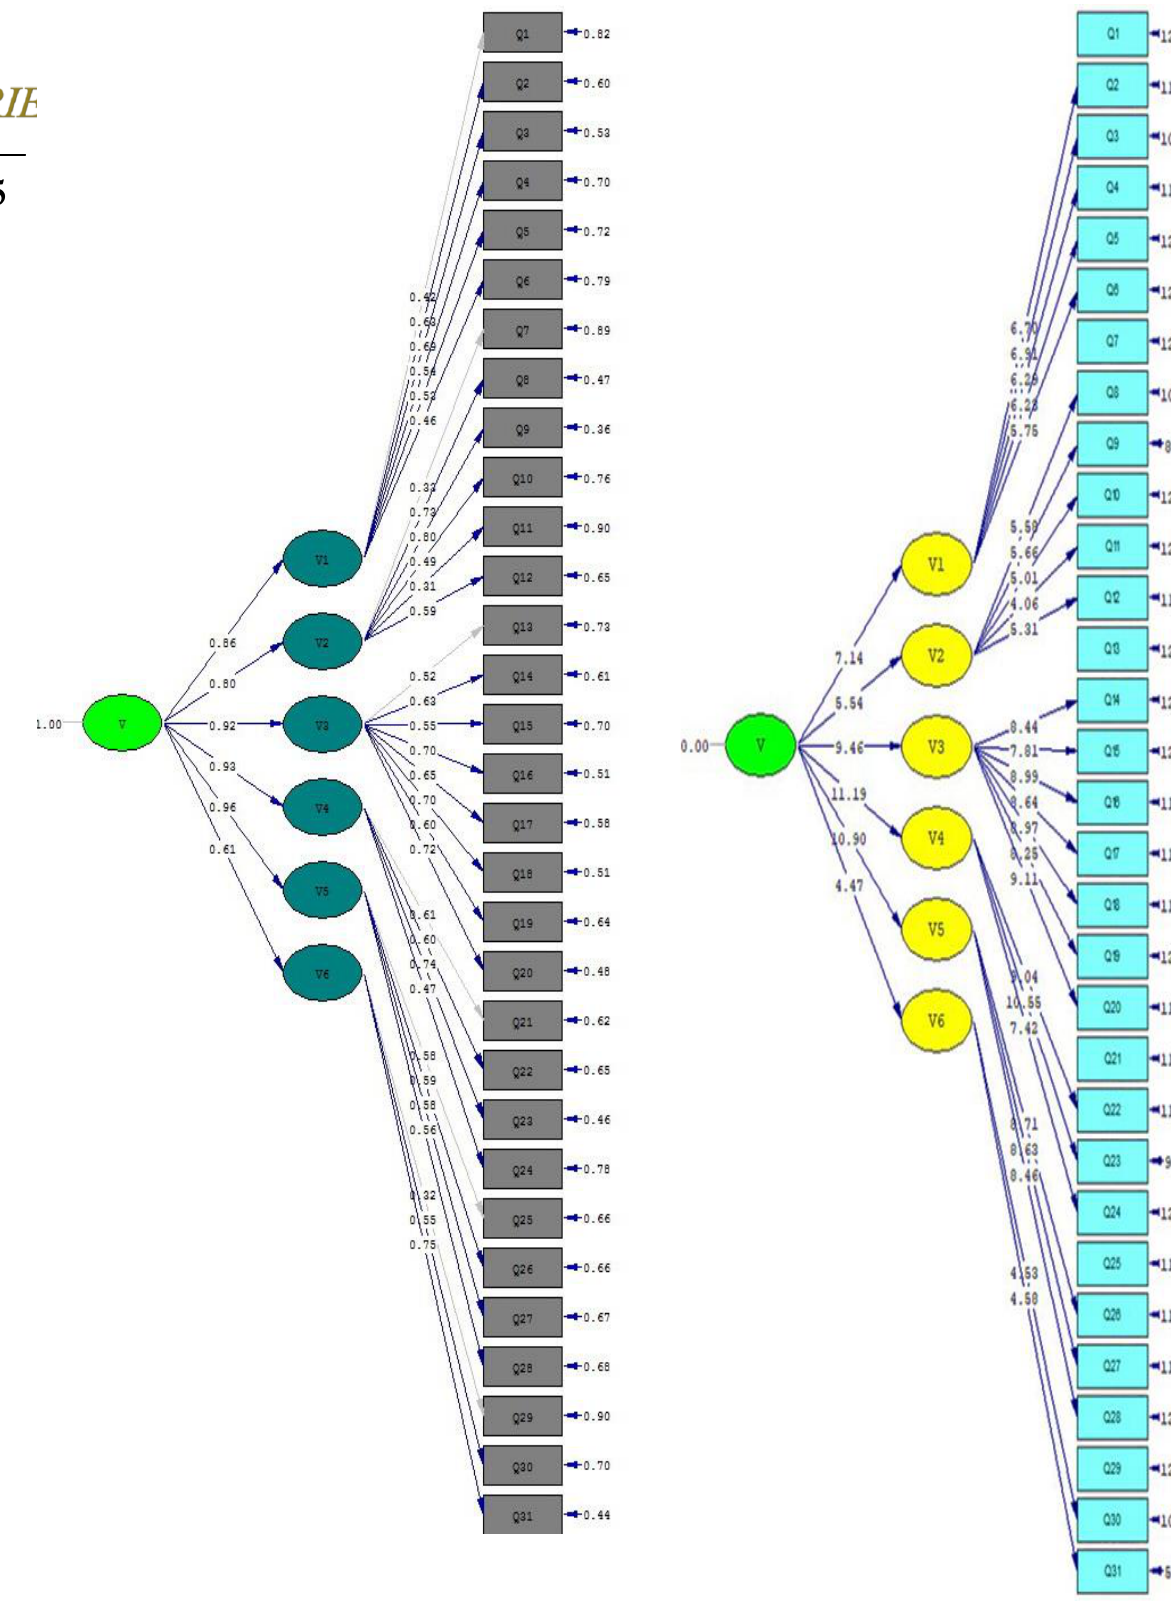
Chi-Square=0.00, df=0, P- value=0.00000,